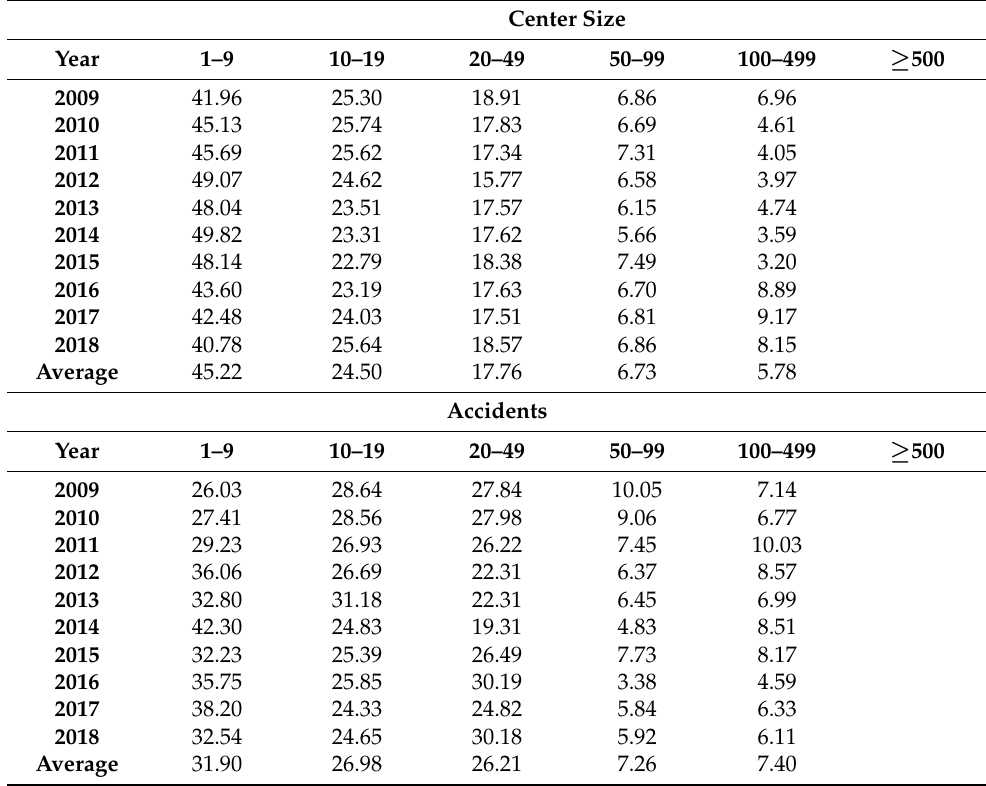
Table 5. Workers and accidents per size in OP